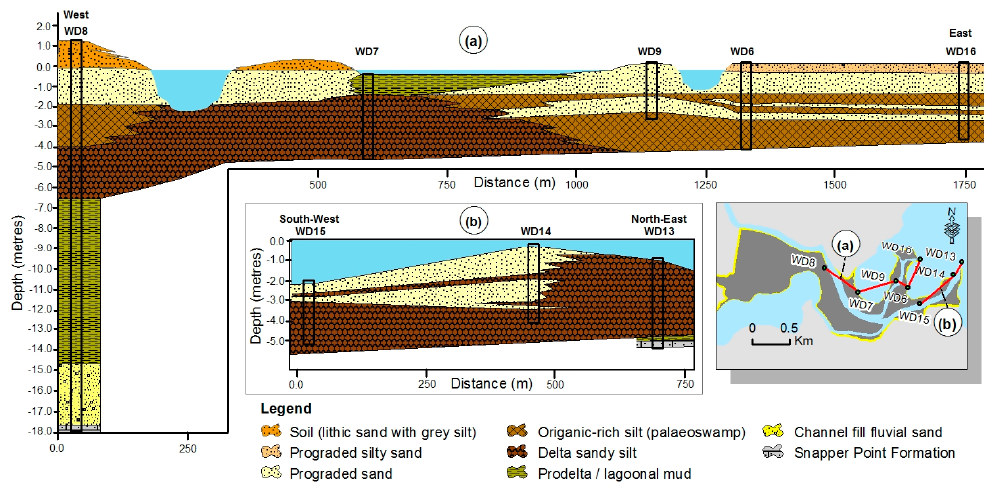
Figure 11. Cross-sections showing the distribution of prograded sand and organic-rich silty sequences in the Wandandian deltaic facies, which provide suitable bases for eco-geomorphic growth. ( a ) Progradation of the western distributary into the embayment in St Georges Basin along vibracores: WD8 (west), WD7, WD9, WD6 and WD16 (east). ( b ) Eastern distributary through drill-holes WD15 (southwest), WD14 and WD13 (northeast). Its eastern extent is controlled by an outcropping to shallow subsurface basement high (after [15,16]).